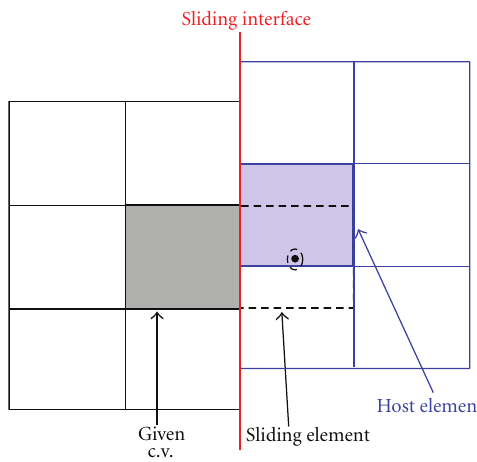
Figure 2: Schematic of the sliding interface